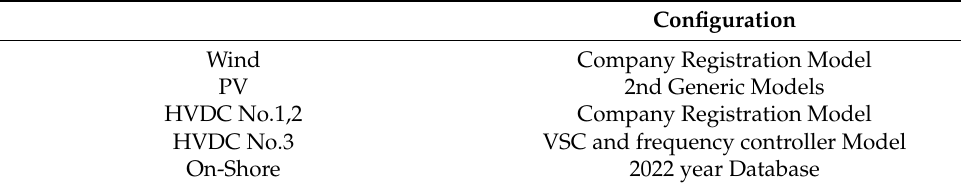
Table 2. Database Table 2. Database configuration.